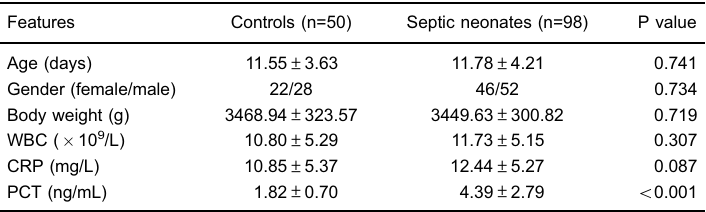
Table 1. Comparison of clinical characteristics between septic neonates and controls.